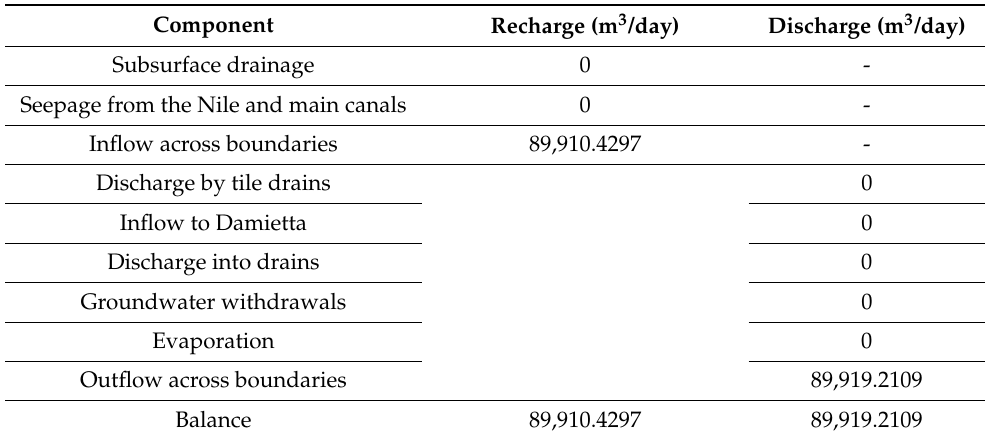
Figure 10. ( a ) Calibration of the head at steady state (2018) and ( b ) calibration of the TDS (mg/L) at steady state (2018). Table 2. Groundwater balance of the study